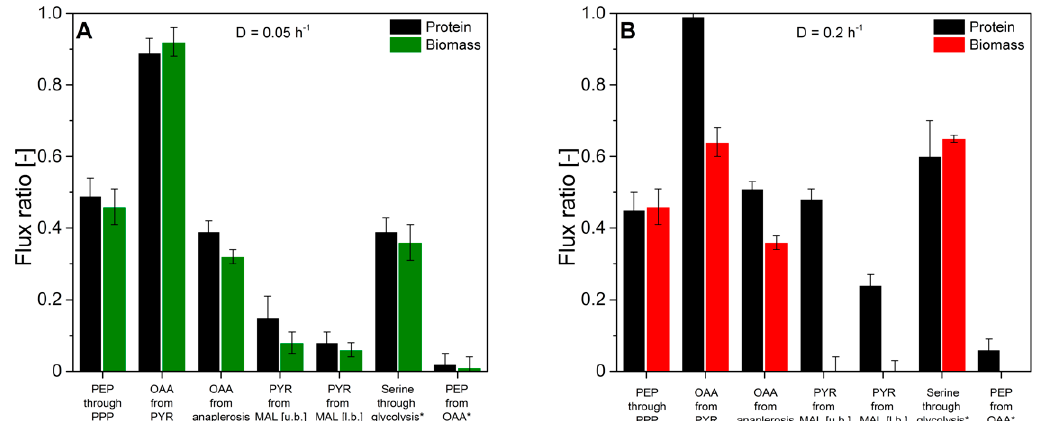
Figure 9. Comparison of intracellular flux ratios of H. polymorpha RB11 conphys cultivated at dilution rates of ( A ) D = 0.05 h − 1 and ( B ) D = 0.2 h − 1 . Flux ratios were determined based on isotope mapping in amino acids from secreted protein and biomass with METAFoR. (PEP = phosphoenolpyruvate, PPP = pentose phosphate pathway, OAA = oxaloacetate, PYR = pyruvate, MAL = malate, u.b. = upper bound, l.b. =lower bound) .